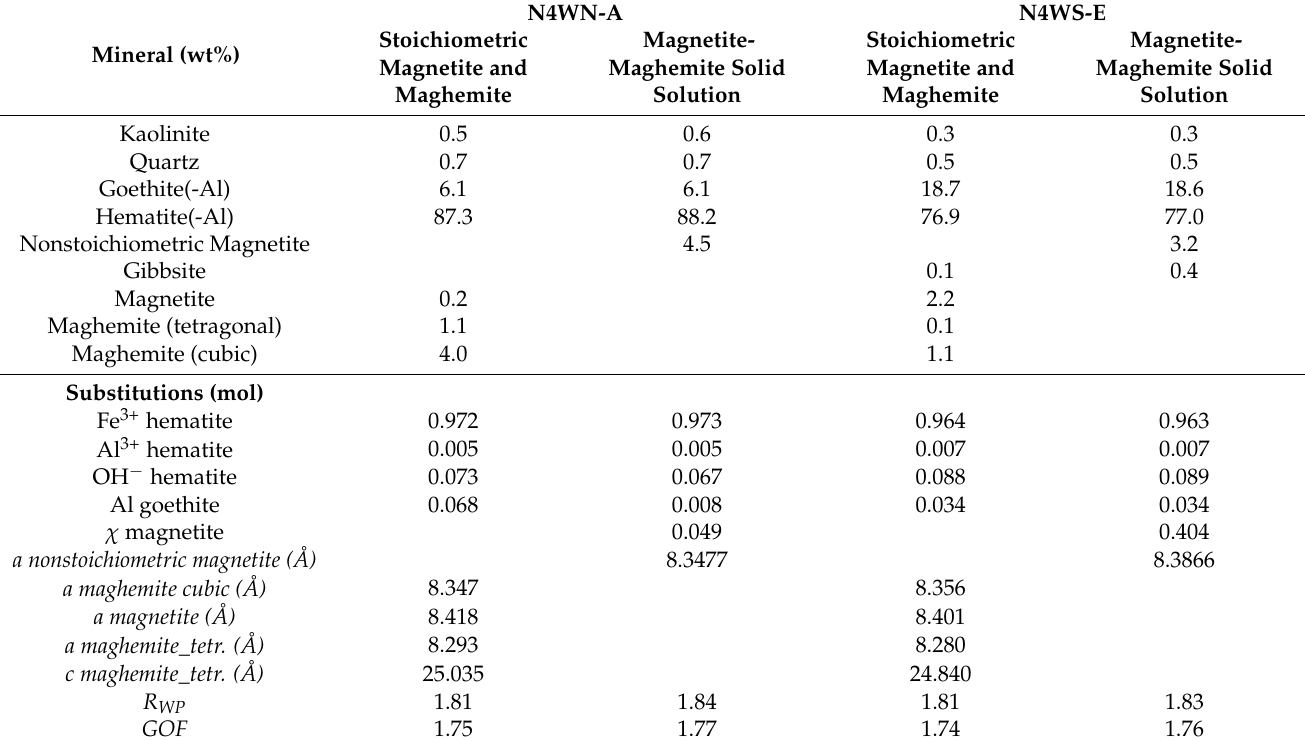
Table 6. Rietveld method quantitative phase analysis, comparing the magnetite-maghemite solid solution approach with the refinement using stoichiometric magnetite, cubic maghemite and tetragonal maghemite structures, for the iron ores from Caraj á